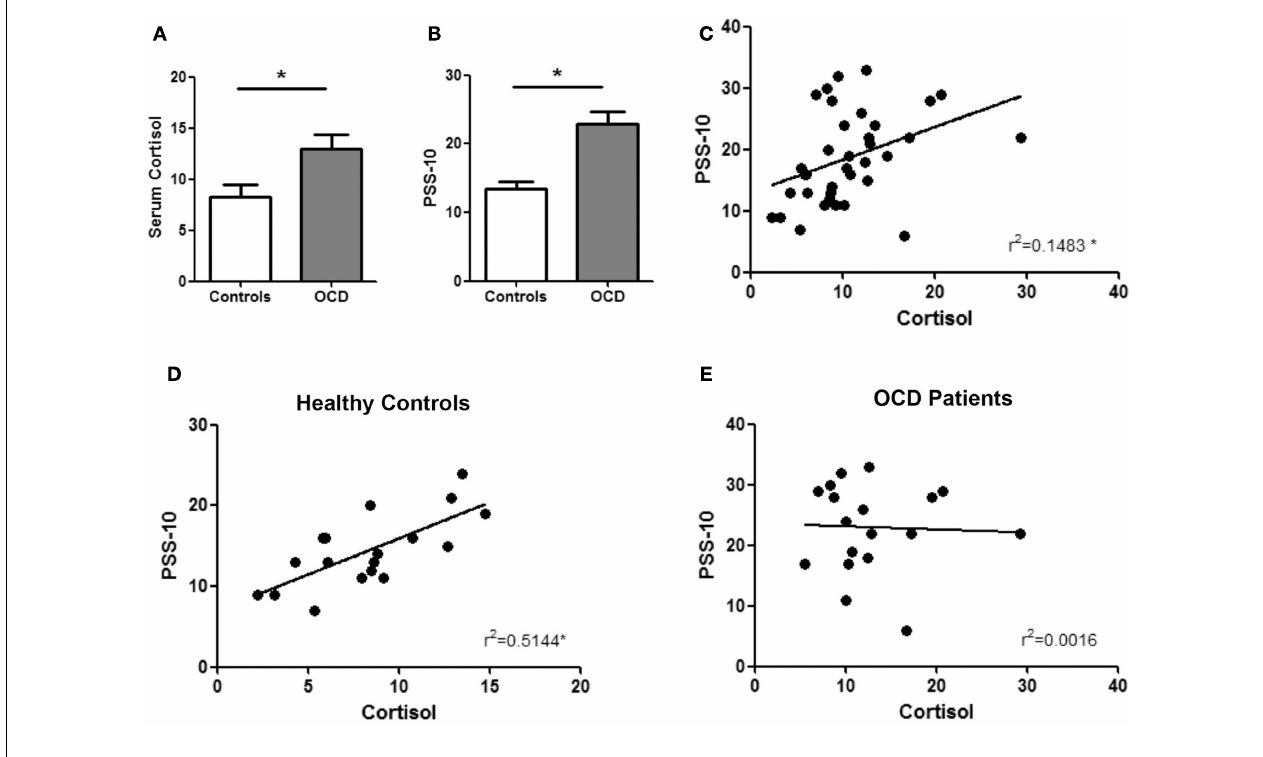
(PSS-10) questionnaire (B) . Importantly, these two measurements were positively correlated (C) . Looking at each group separately, cortisol and PSS-10 score correlate in healthy controls (D) but not in OCD patients (E) * p < 0.05.